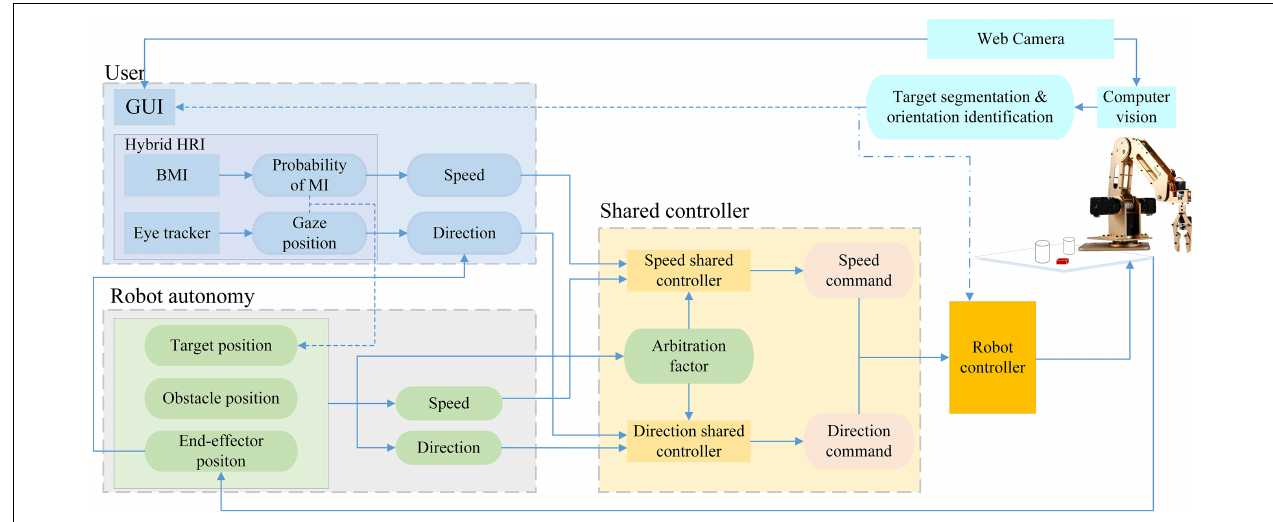
FIGURE 2 | The block diagram of the proposed semi-autonomous robotic system. The dotted arrows denote the information flows only for Stage 1, and the dot-dashed arrow represents the information flow only for Stage 3.